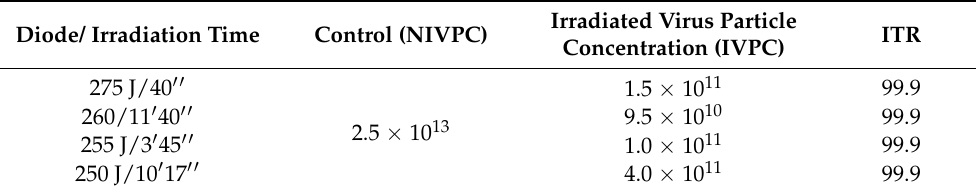
Table 4. Human coronavirus HCoV-OC43 infectious titer reduction using ultraviolet C (UV-C) 275 nm in time exposure. Analyses of cytopathic effect (CPE) and UV virial particles (VP) in infectivity assay.